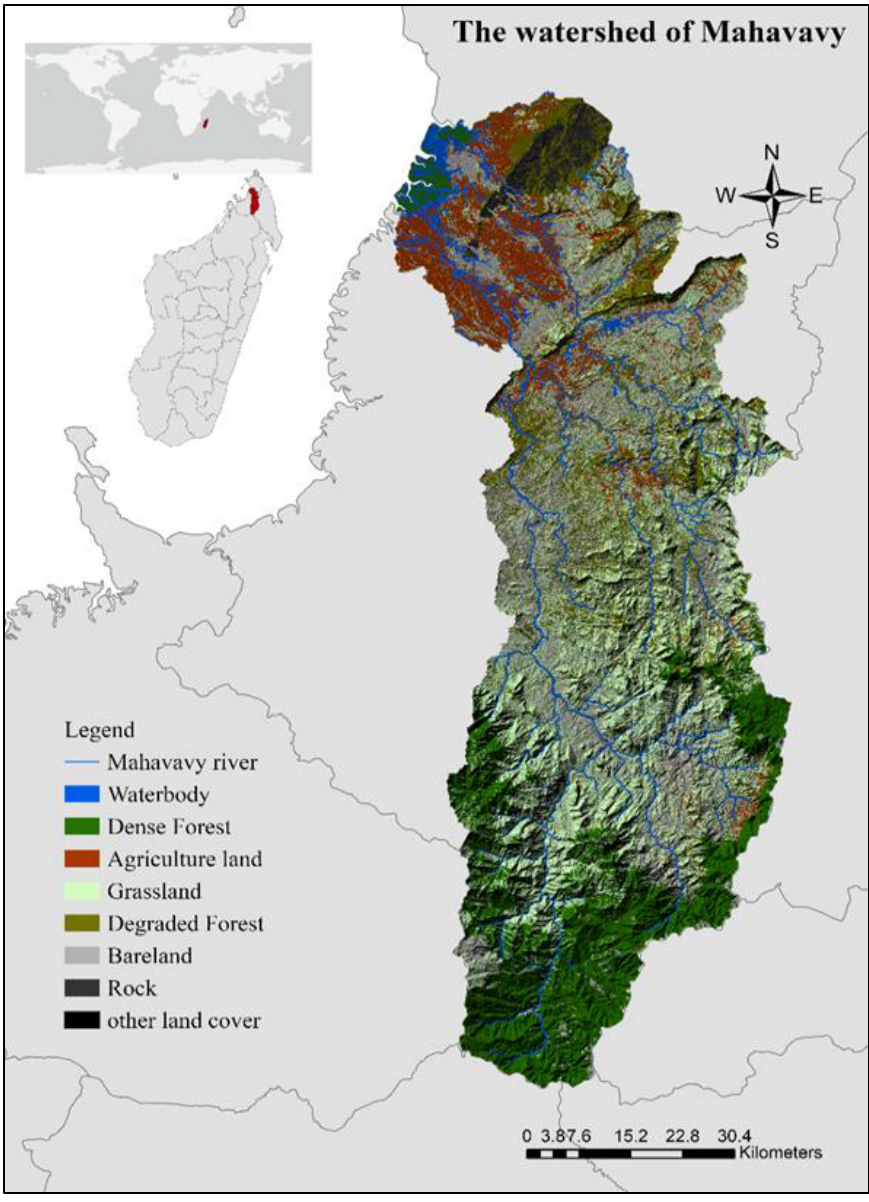
Figure 1. The Mahavavy watershed in northwestern Madagascar.